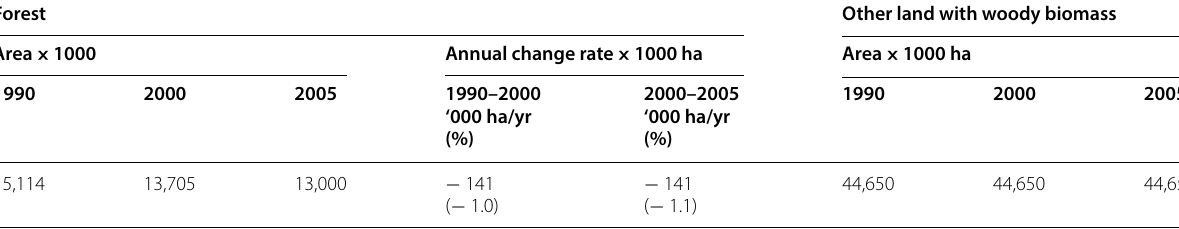
Source: FAO (2005)